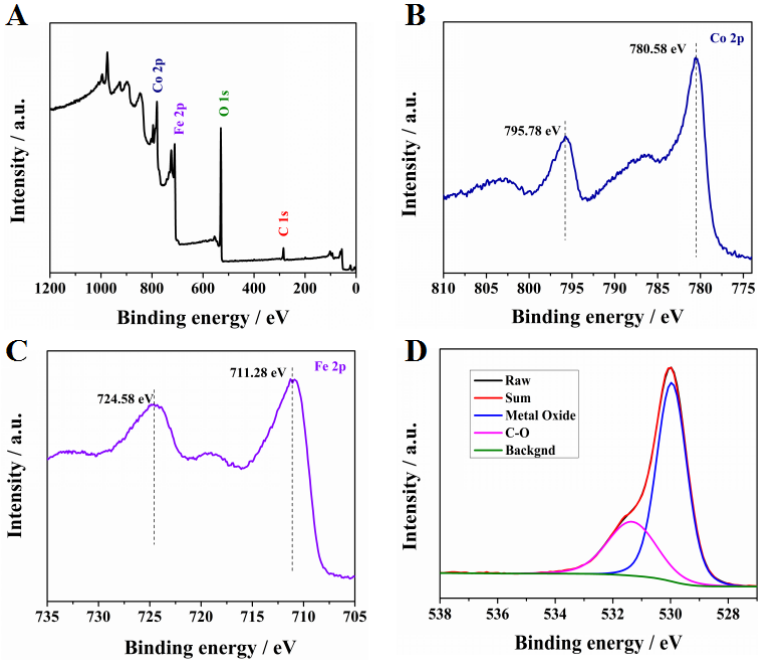
Figure 4. XPS spectra of CF300: ( A ) survey spectrum, high resolution XPS spectra of ( B ) Co 2p, ( C ) Fe 2p, and ( D ) O 1s.